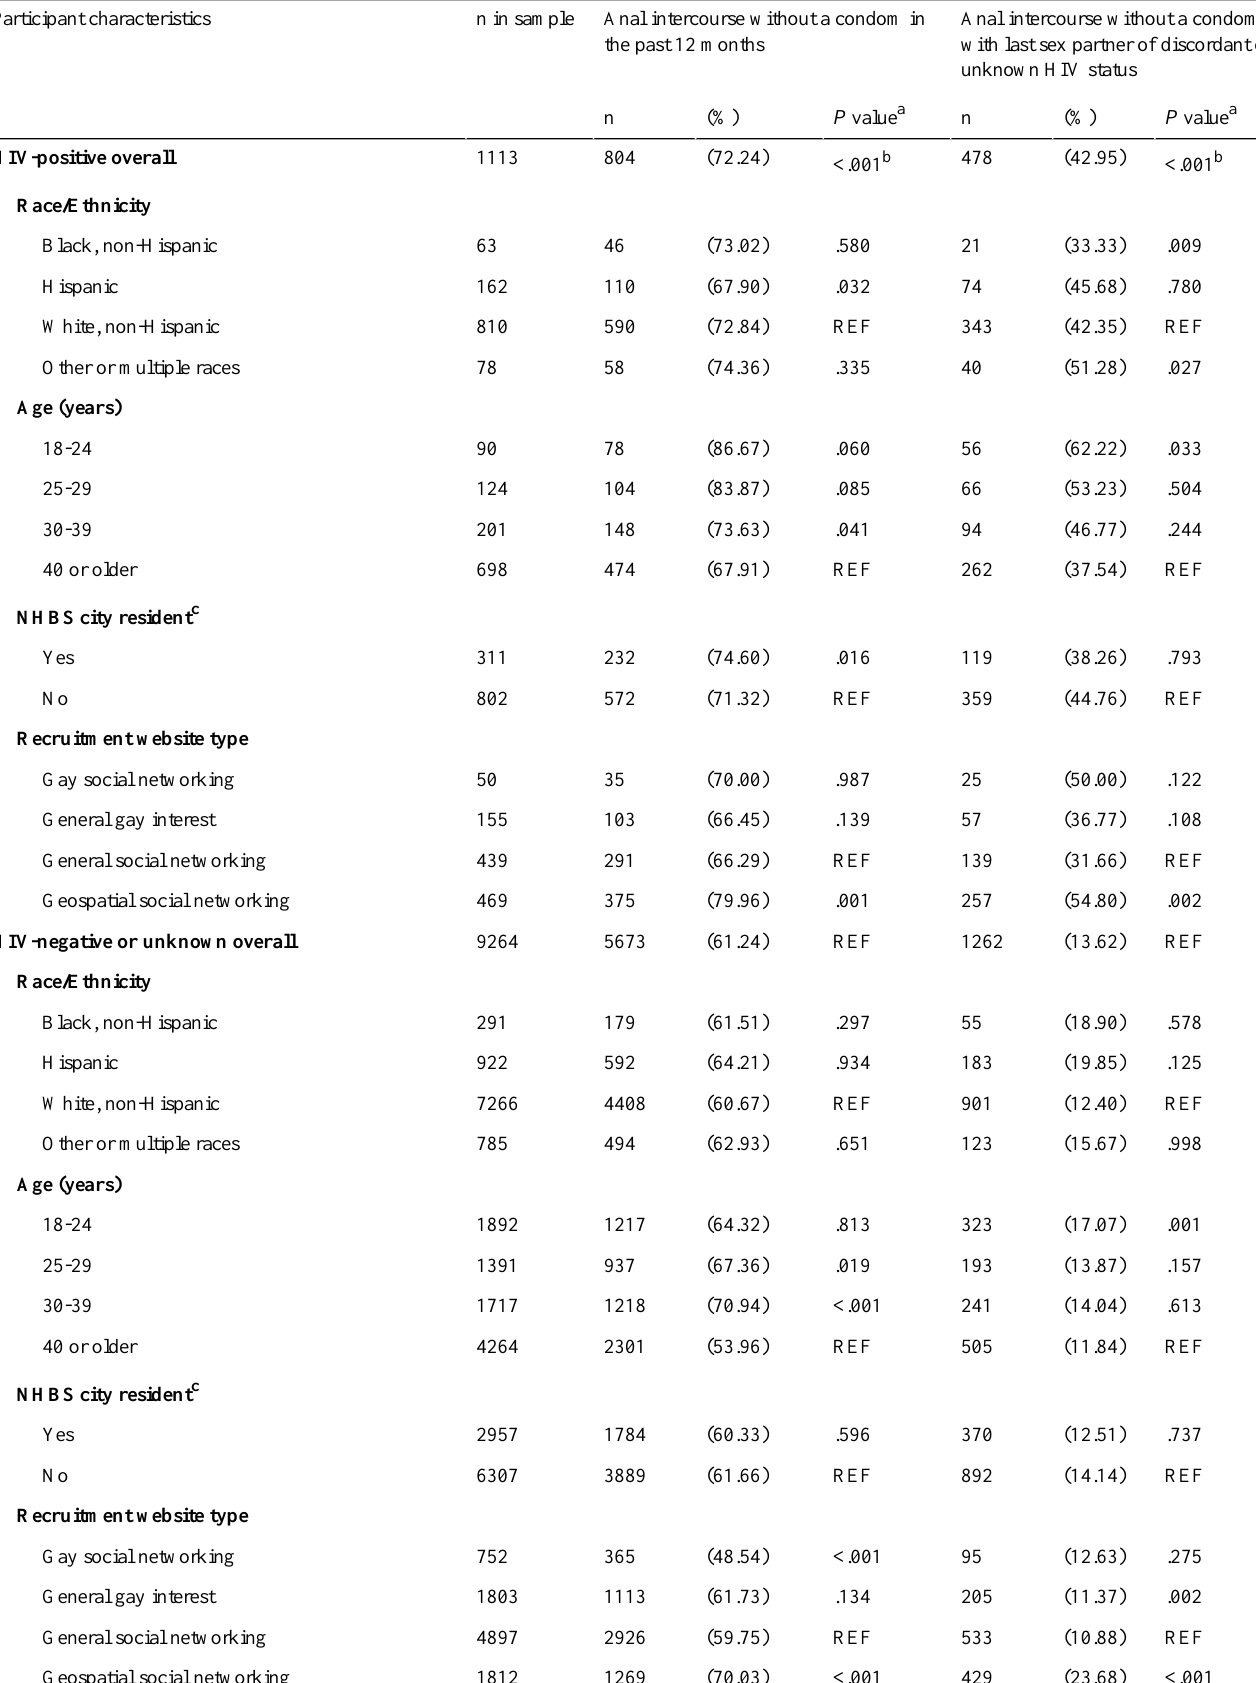
Table 3. Sexual Behaviors with Male Partners of MSM Participants in the American Men's Internet Survey, United States, 2013.